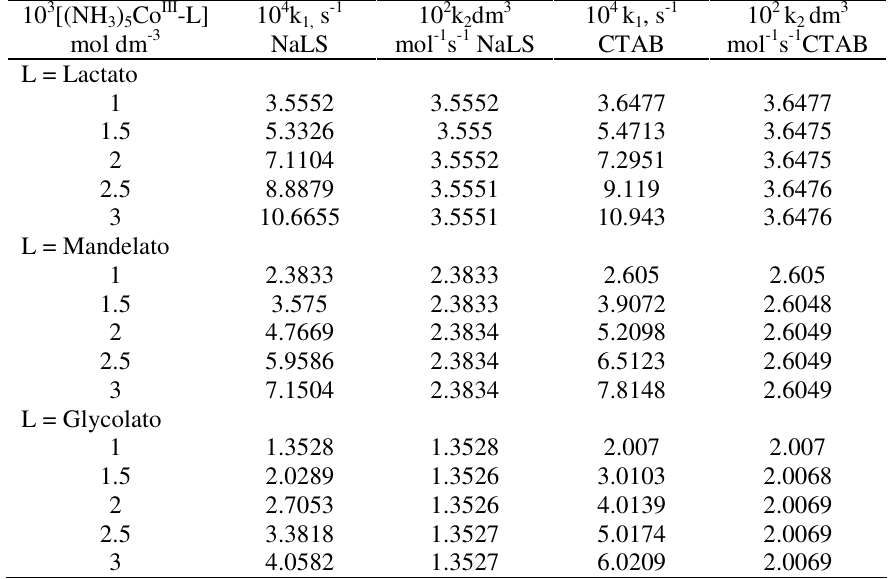
Table 4. First order rate constants for PFC oxidation of Co(III) complexes of α -hydroxy acids at 35±0.2 0